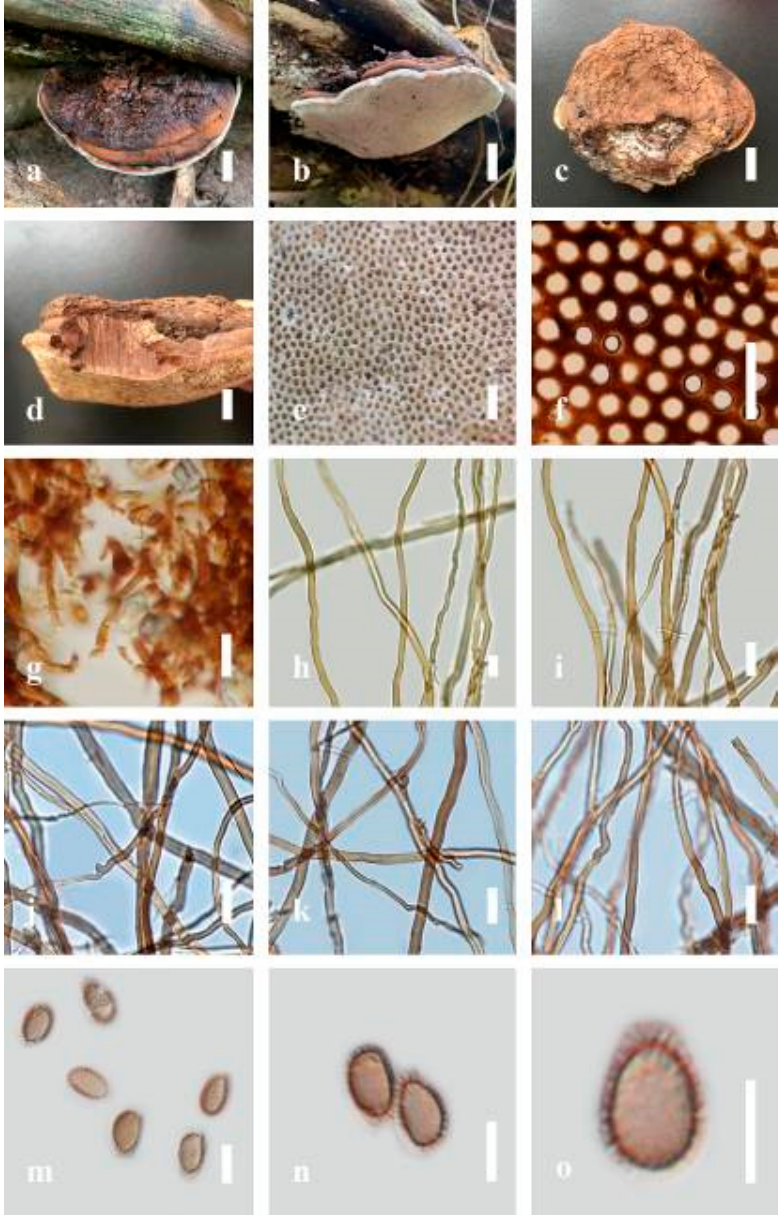
Figure 24. Morphology characteristics of Ganoderma ellipsoideum (MFLU 19 ‐ 2221): ( a ) the upper surface of mature basidiomes when fresh; ( b ) the lower surface of mature basidiomes when fresh. ( c ) the upper surface of mature basidiomes when dried; ( d ) margin; ( e , f ) pore characteristics; ( g ) hyphae of tube layers; ( h , i ) hyphae from trama in KOH; ( j – l ) hyphae from trama in KOH; ( m – o ) basidiospores in KOH reagent. Scale bars: ( a – d ) = 2 cm, ( e , f ) = 500 μ m, ( g ) = 200 μ m, ( g – l ) = 20 μ m, ( m , n ) = 5 μ m.